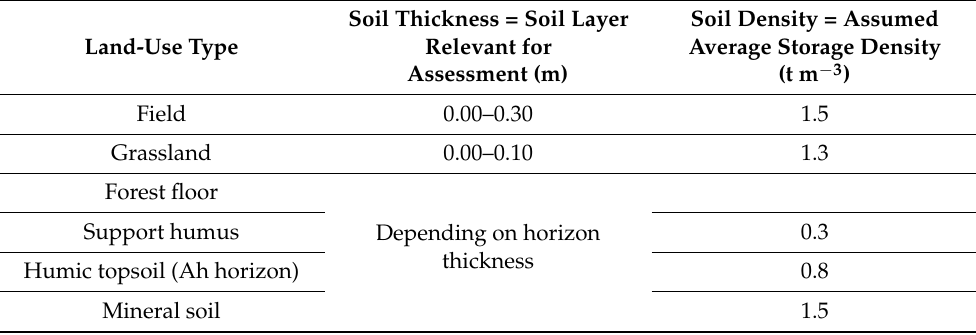
Table 6. Convention for the inclusion of soil thickness and storage density in the calculation of precipitation-limiting values for the protection of the